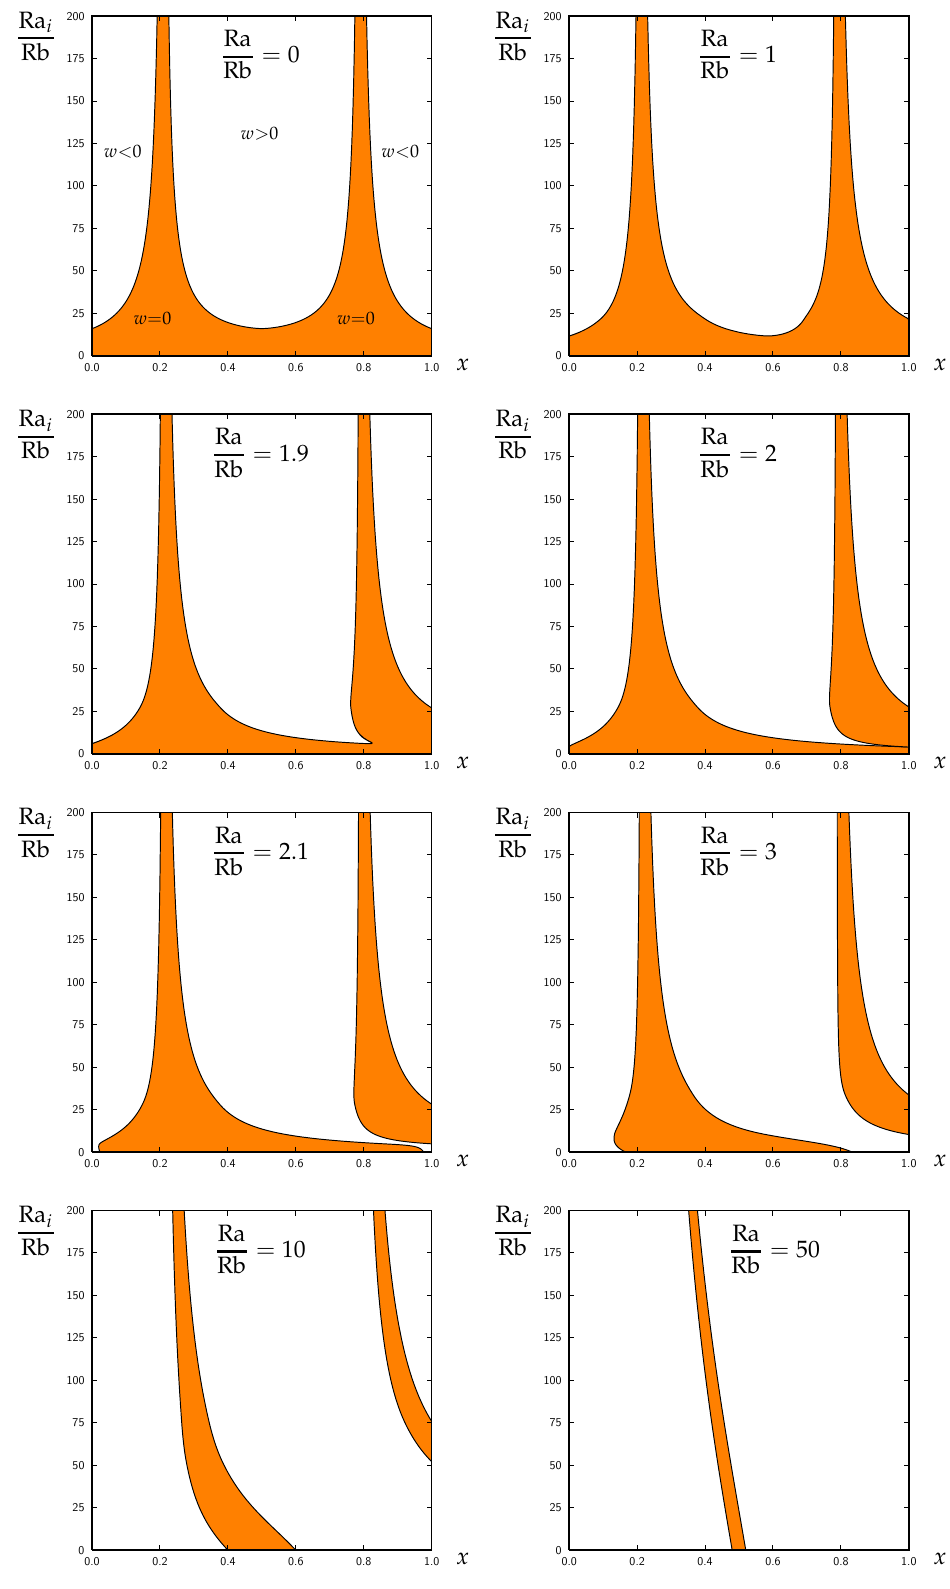
Figure 4. The evolution of the yield surfaces with Ra i /Rb for the given values of Ra/Rb. The stagnant regions are shaded in orange. The flowing region adjacent to x = 0 always corresponds to downflow, w < 0.